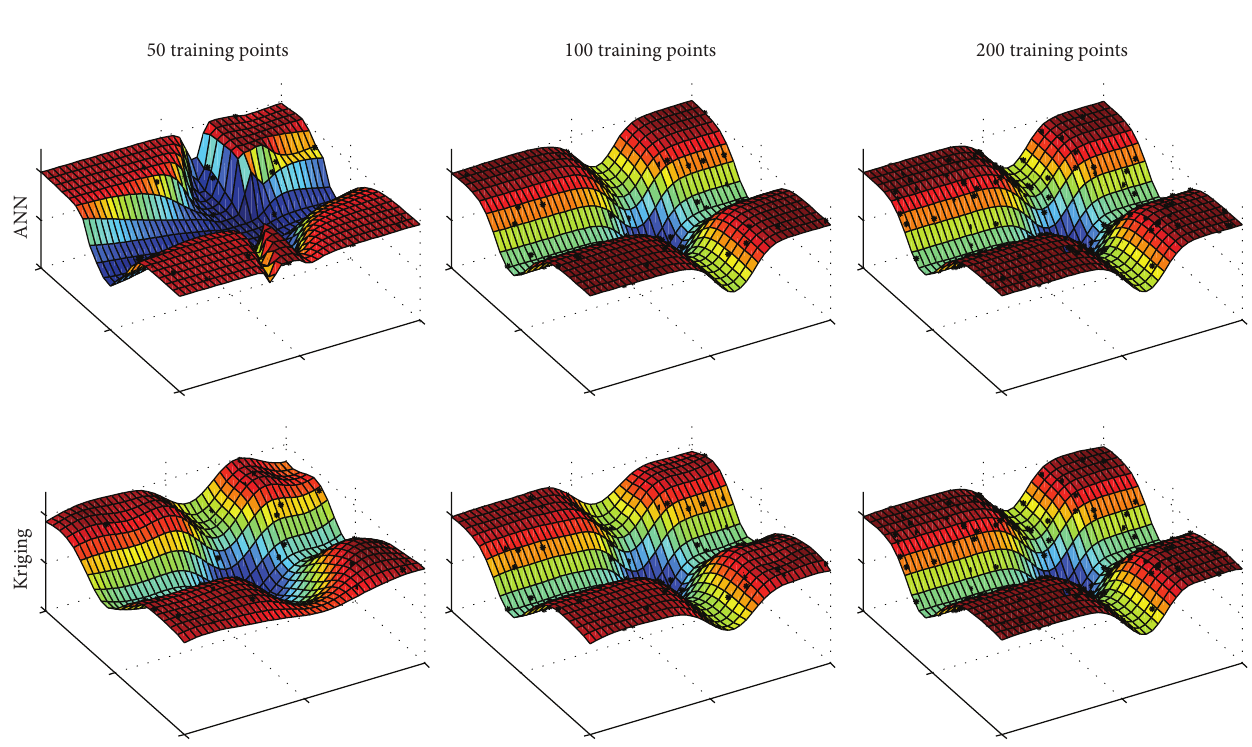
Figure 4: Metamodels of the Michalewicz function (10) obtained using the ANN and Kriging methods, based on 50, 100, and 200 experimental